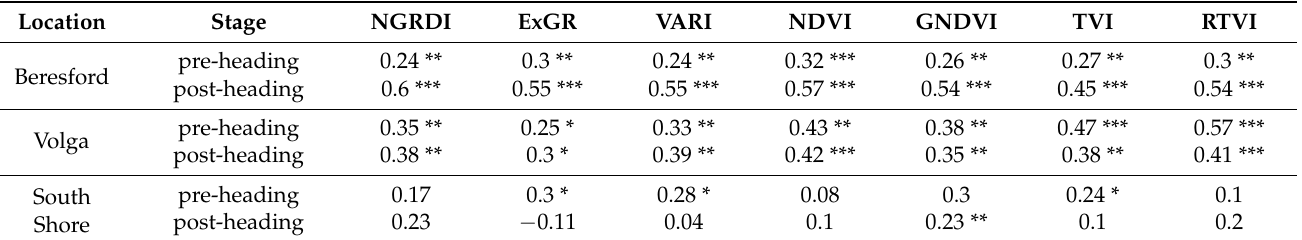
Table 4. Pearson correlation coefficients ( r ) between dry biomass yield and VIs from pre- and post-heading flights.